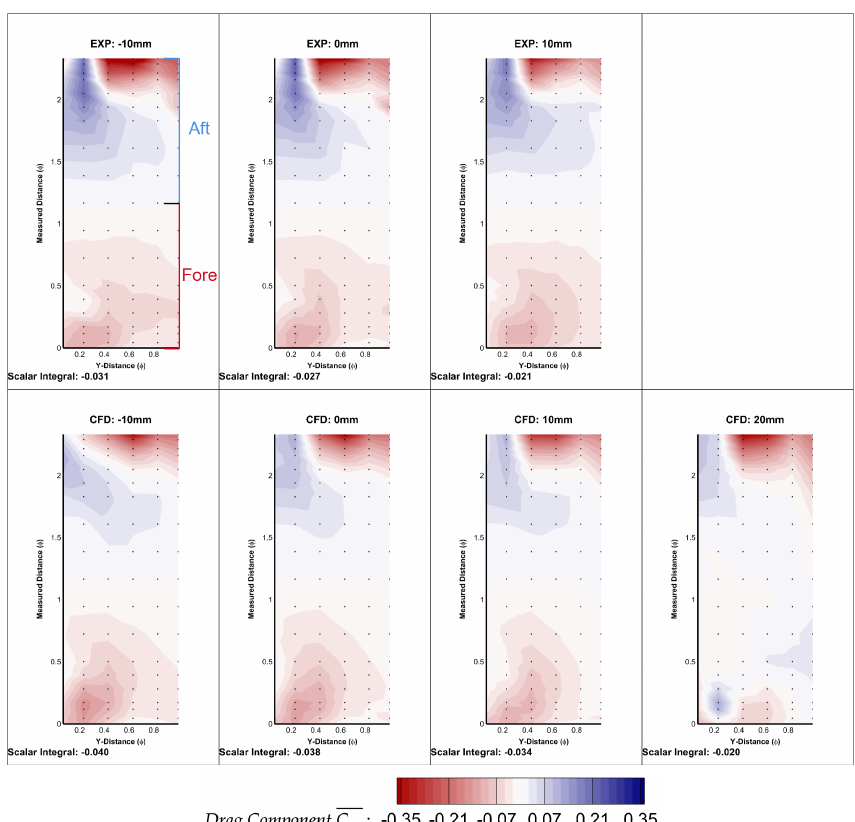
Figure 23. Wheel displacement wheel arch pressures: experimental and computational, drag